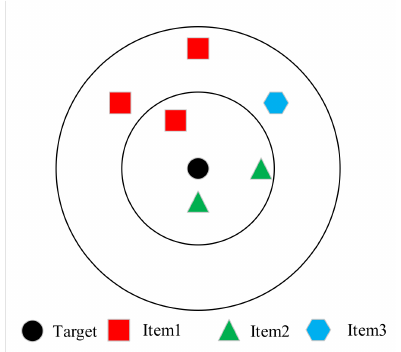
Figure 4. Examples of K-NN